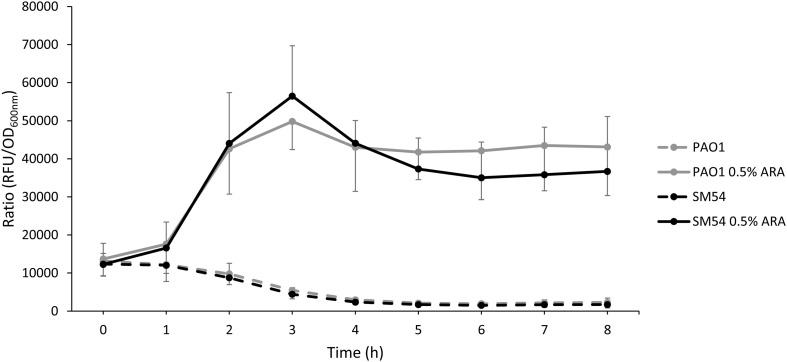
Accumulation of the red fluorescent protein mCherry. Strains PAO1 and SM54 were grown in Mueller-Hinton broth containing 10 or 2 μg mL– 1 of Gentamicin, respectively, used as selection marker of plasmid pJN105. The transcription of the mCherry coding gene was induced with 0.5% of arabinose and the accumulation of the fluorescent protein was monitored using a microplate reader (Ex 590 nm, Em 610 nm) (solid lines). Non-induced cultures were used as controls (dashed lines). Results represent mean values of three independent experiments and error bars represent standard deviation.